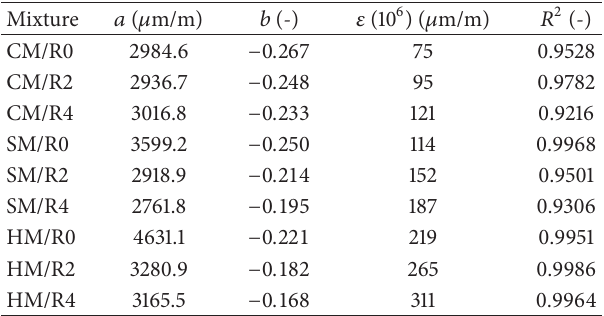
Table 8: Regression coefficients of the fatigue curves: 𝑁 1 approach for aged mixtures.